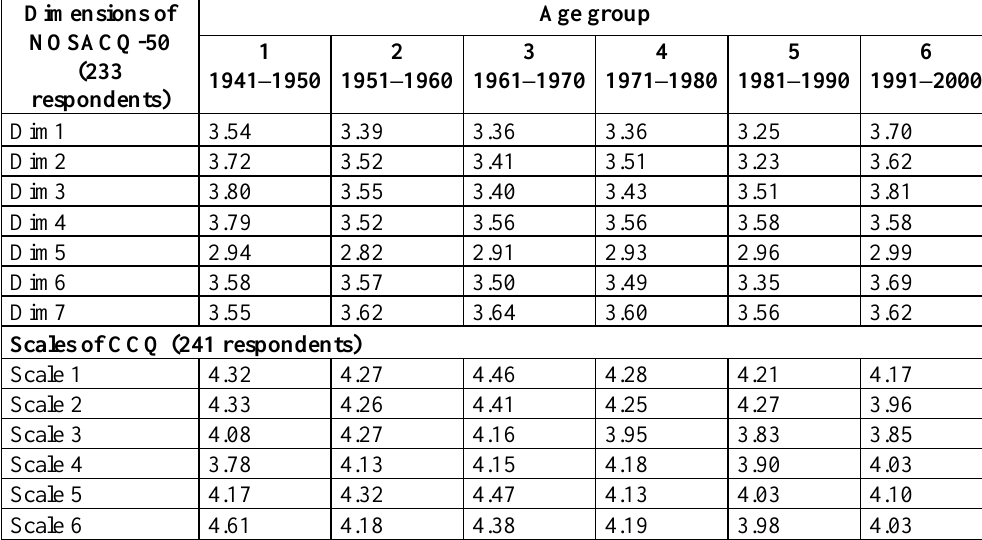
Table 1. The Average Responses of Different Dimensions of Safety Climate by Age